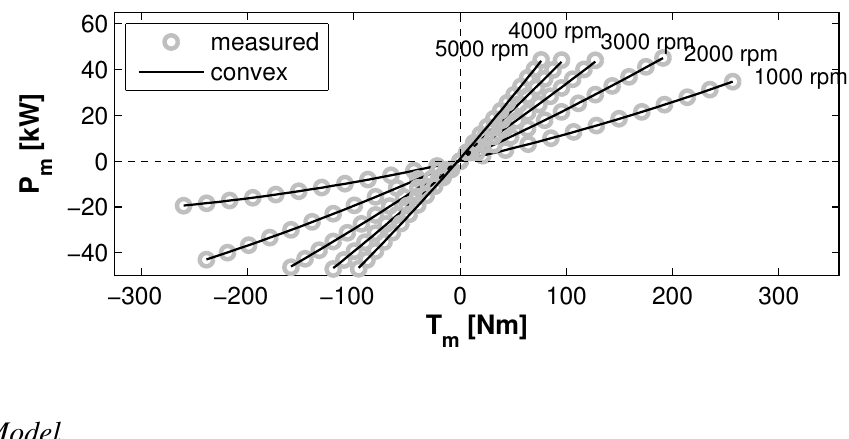
Figure 2. Fit of the convex motor